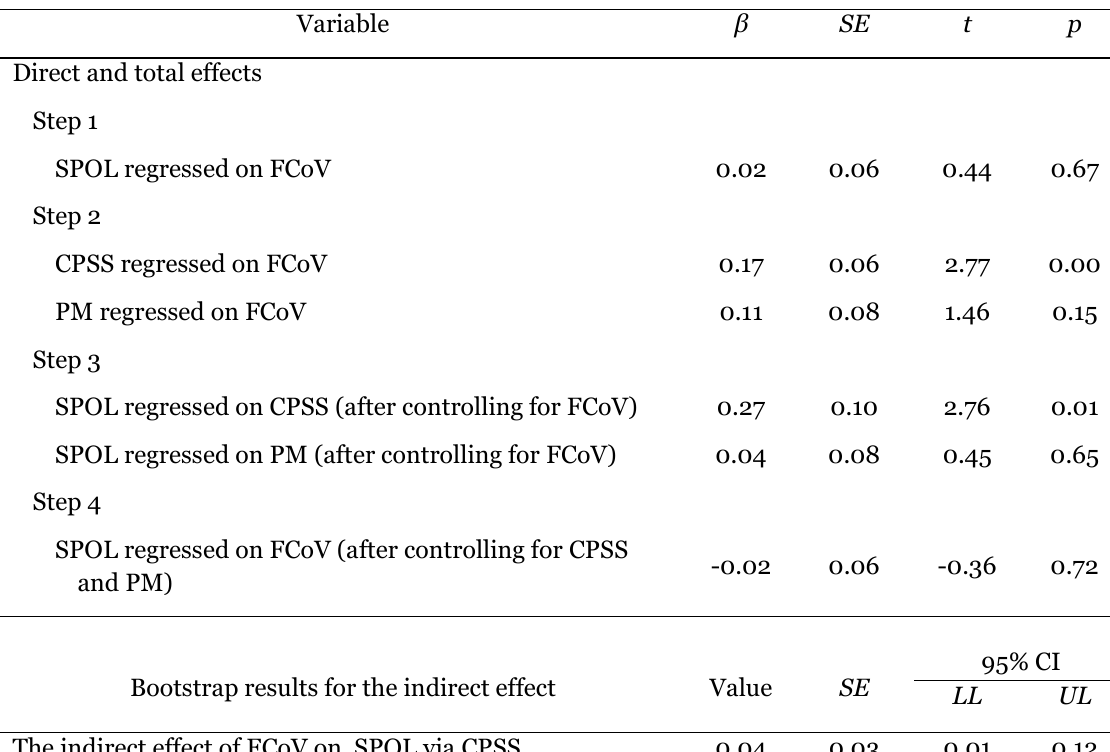
Regression Results for Parallel Mediation in Malaysia